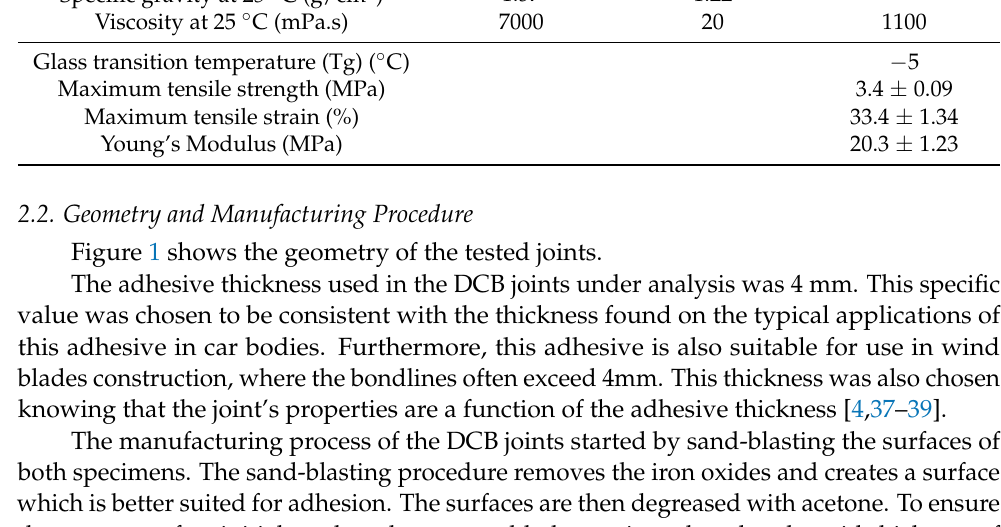
Table 1. Physical and mechanical properties of the polyurethane adhesive.